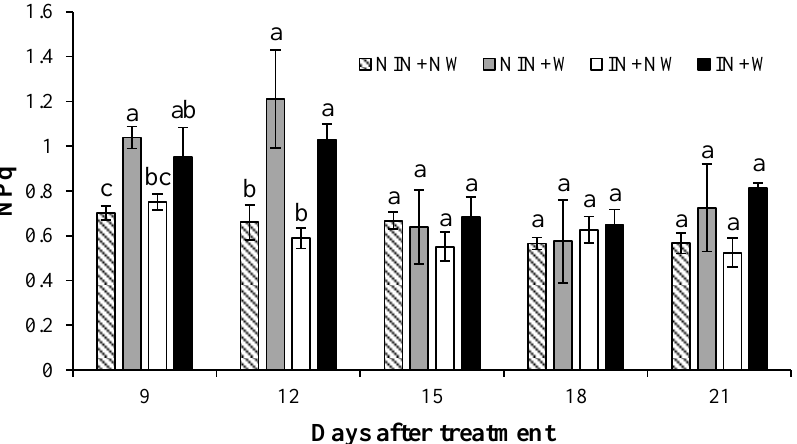
Figure 5. NPq in R. sativus under waterlogged conditions and inoculated with A. brasilense. Averages followed by different letters at each sampling point show statistical differences according to Tukey’s test ( p < 0.05). Vertical bars in each average indicate standard error ( n = 11).